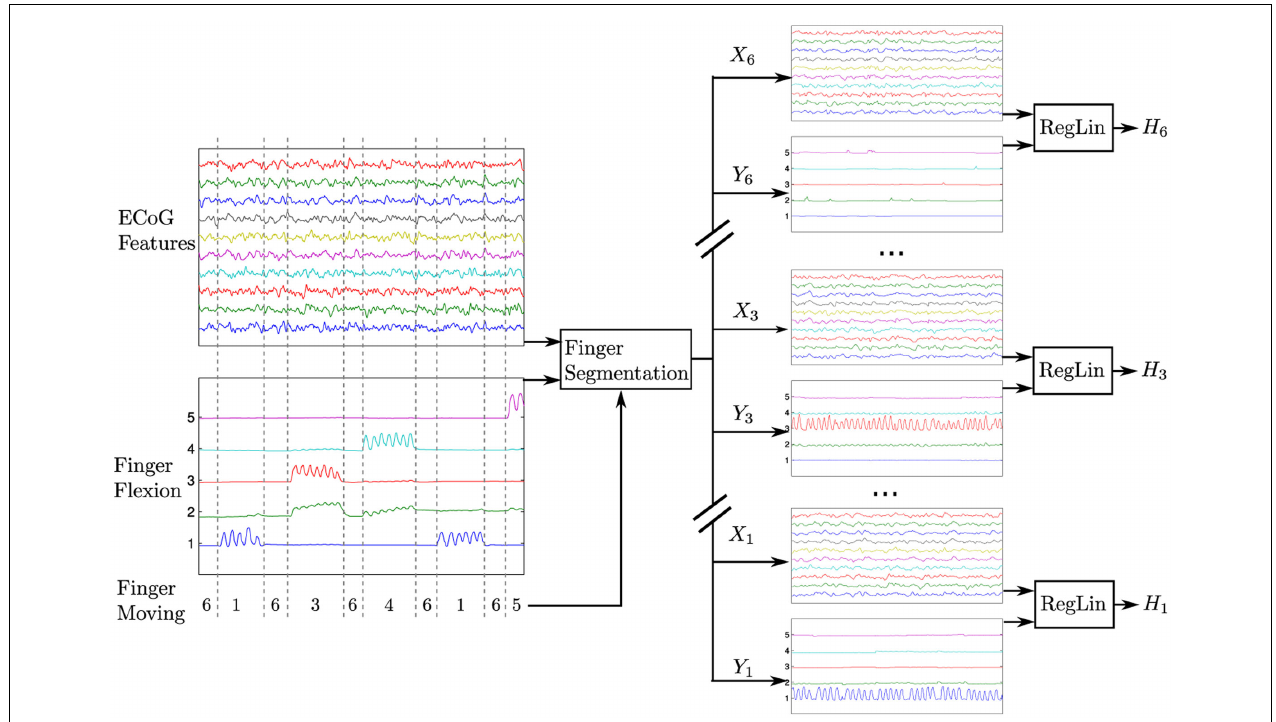
FIGURE 3 |Workflow of the learning sets extraction (X k andY k ) and estimation of the coefficient matrix H k .